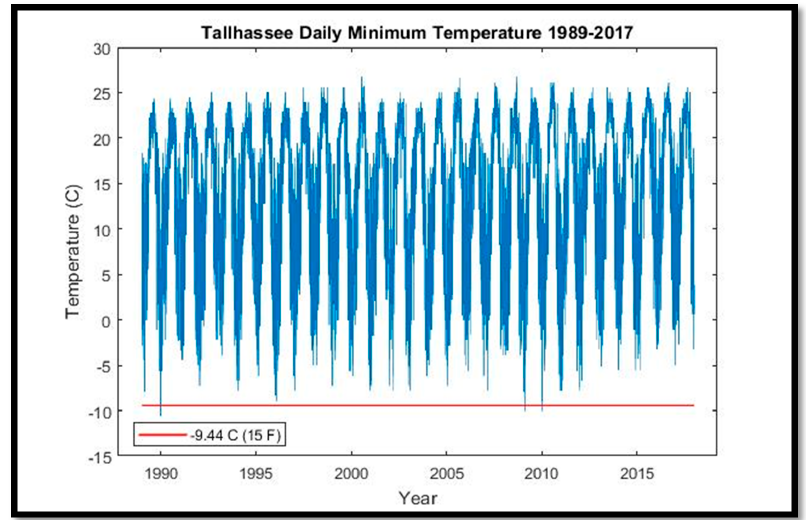
Figure 8. Daily minimum temperature recorded at the Tallahassee Regional Airport, Florida, from 1989 to 2017. S. palmetto “hardiness” threshold is plotted in